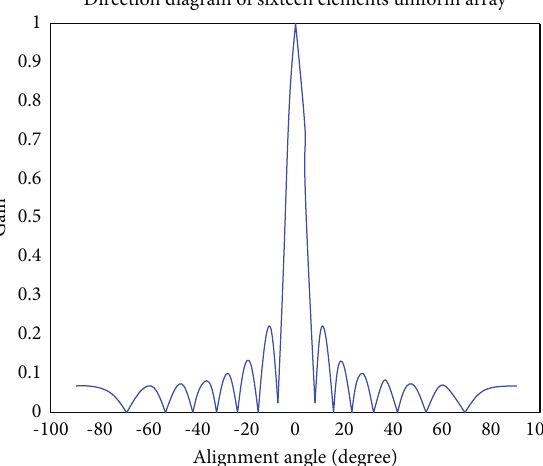
Figure 4: Directional diagram of 16-element uniform linear array.